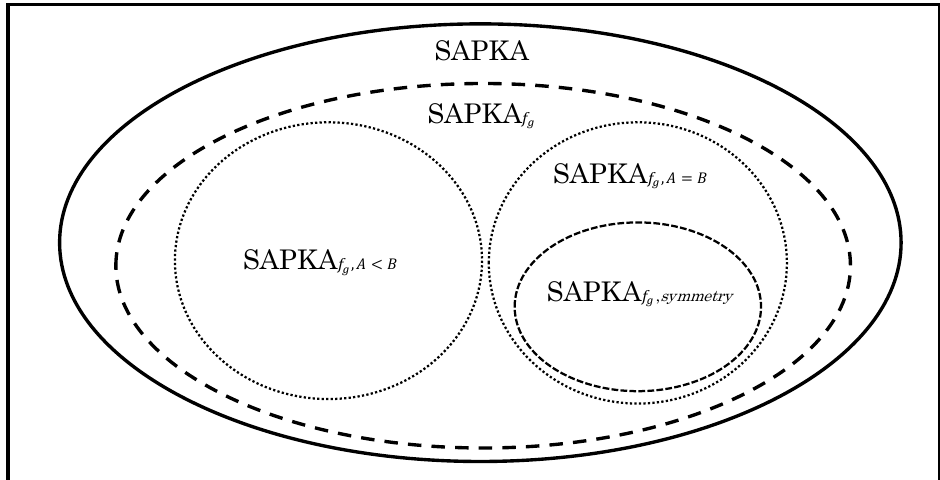
Figure 3. Inclusion relations between subclasses of